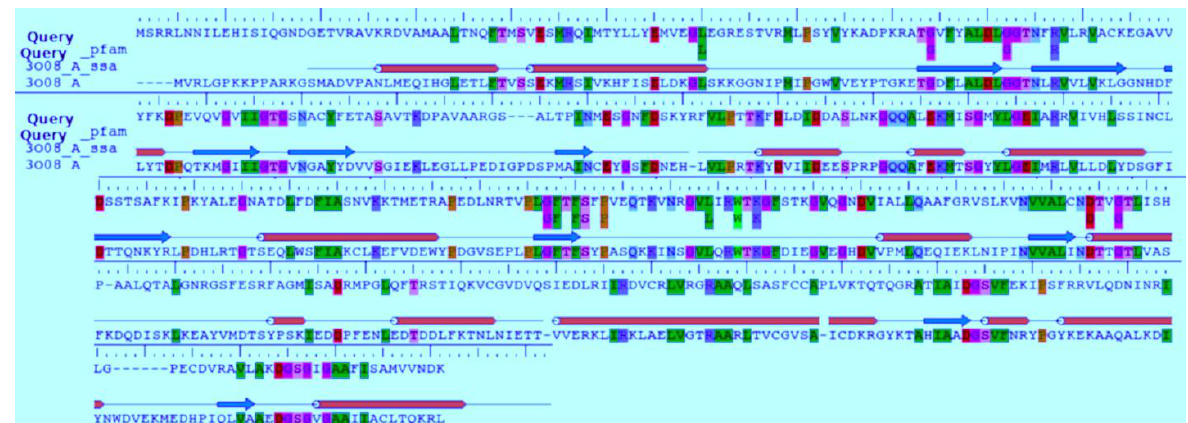
Figure 2. The secondary structure and conservation information of the target. Secondary structure predictions for the target are annotated as Hs (helices) and Es (beta sheets), while the structure of the template is shown as blue arrows for beta sheets and orange cylinders for alpha helices. Globally conserved regions are annotated as a separate row.